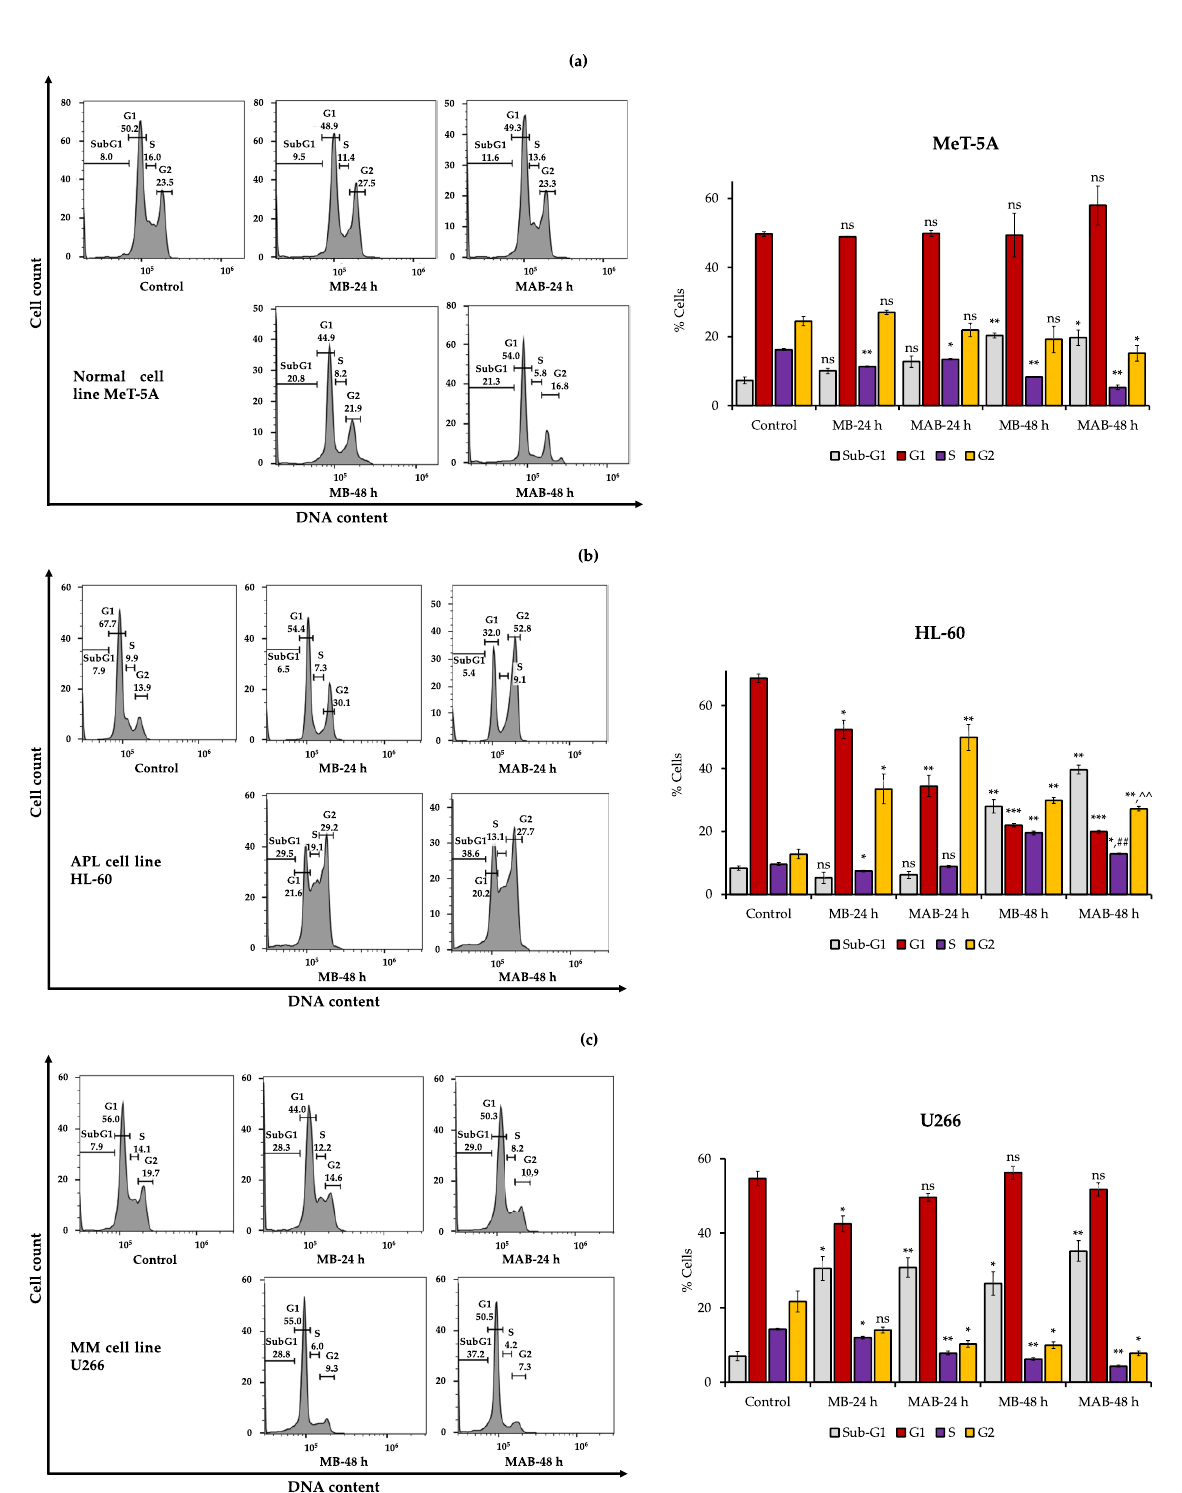
Figure 3. Effects of momilactone B (MB) and the mixture of momilactone A and B (MAB) (1:1, w/w ) at 5 µM on the cell cycle of ( a ) non-cancerous (MeT-5A), ( b ) acute promyelocytic leukemia (HL-60), and ( c ) multiple myeloma (U266) cell lines after 24 and 48 h. Statistical significance was determined by the t -test. * p < 0.05 versus control, ** p < 0.01 versus control, *** p < 0.01 versus control, ˆˆ p < 0.01 versus MAB-24 h, ## p < 0.01 versus MB-48 h. ns, not significant versus